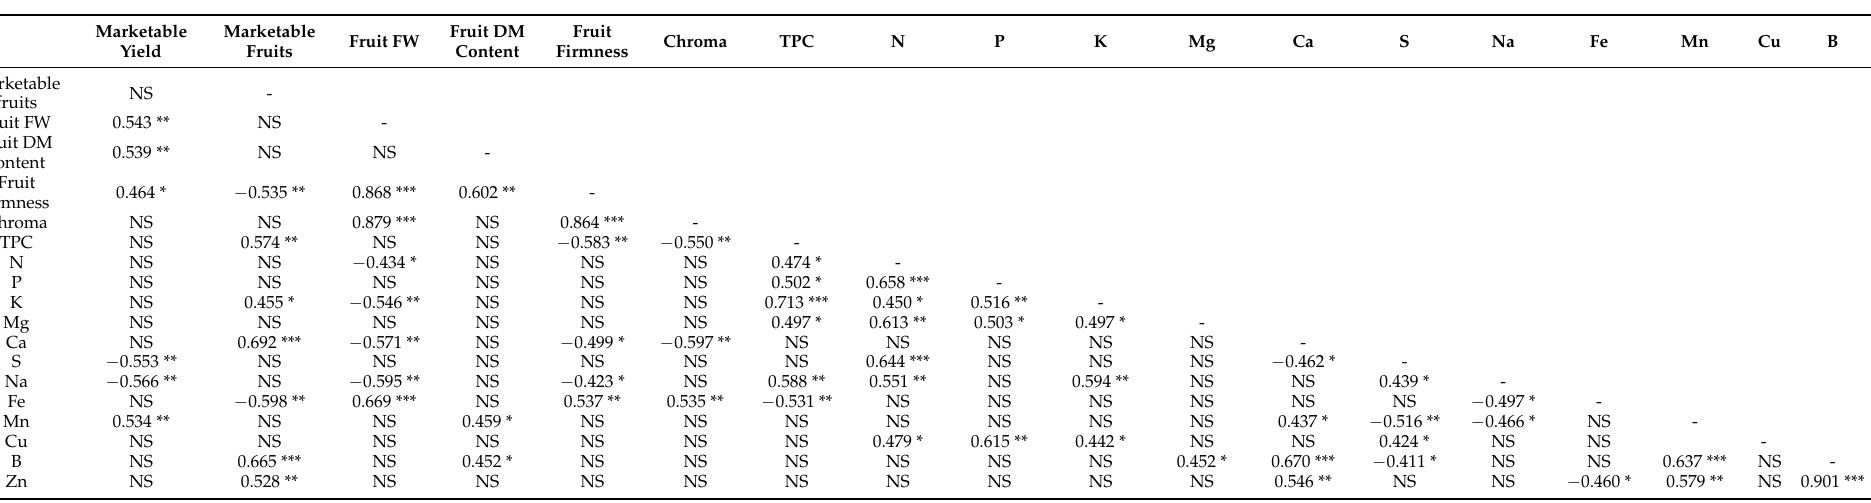
Table 7. Pearson’s product-moment correlation coefficients (r) among variables. *, ** and *** indicate significance at p ≤ 0.05, 0.01 and 0.001, respectively. NS: not